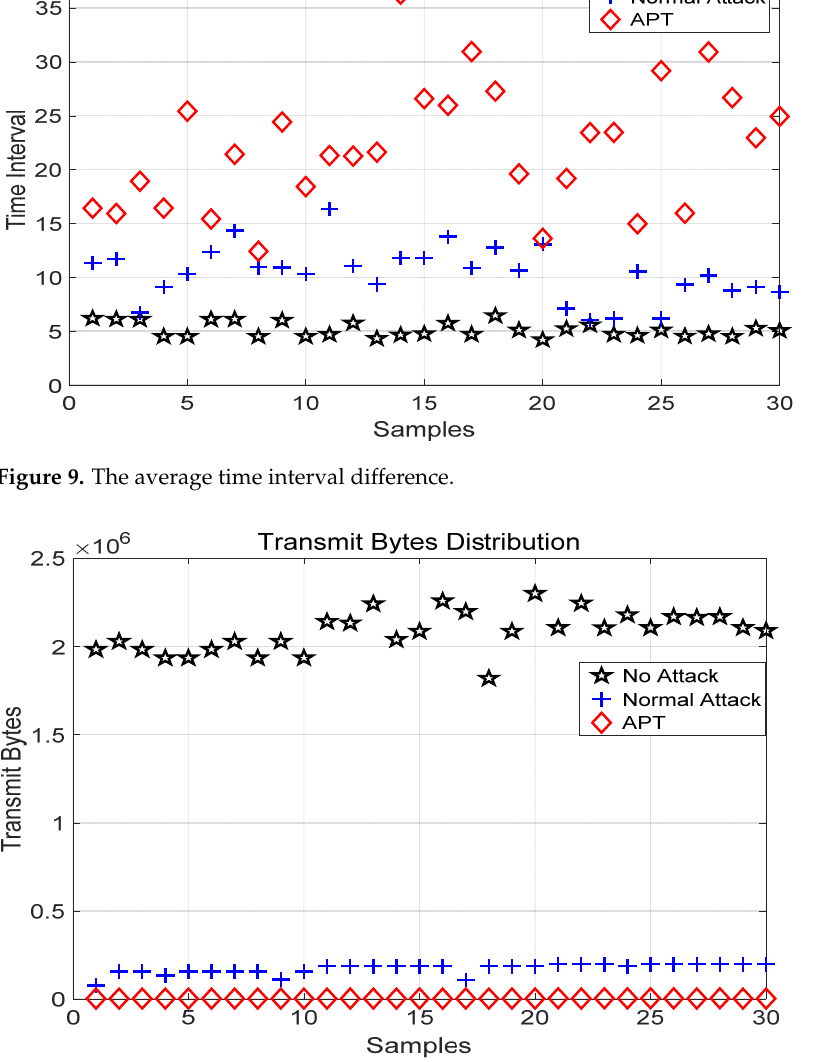
Table 3. Reference values of the area.